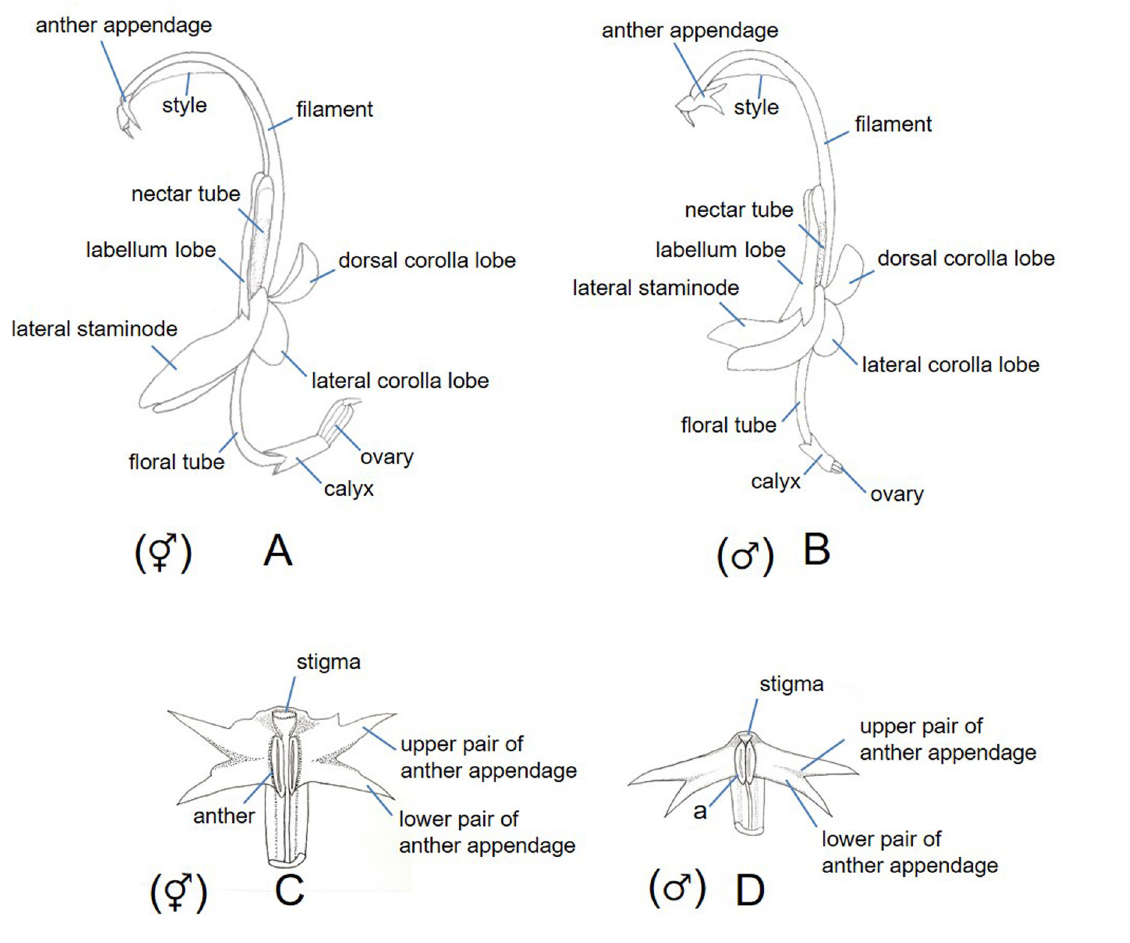
Fig. 3. Parts of the hermaphrodite and functionally male flowers. A . c flower. B . ♂ flower. C . Anther appendages of c flower. D . Anther appendages of ♂ flower. Drawing: S. Sangvirotjanapat from M.F. Newman 2561 leg. ( G. expansa Wall. ex